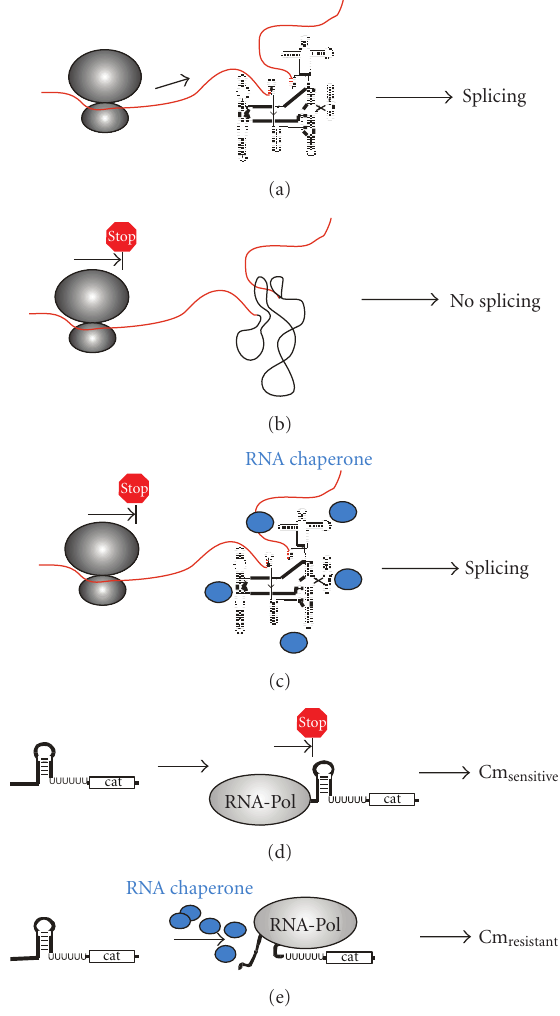
Figure 2: In vivo chaperone assays. (a–c) show the in vivo folding trap assay: (a) In the presence of translation, the group I intron folds correctly. (b) In the absence of translation, misfolding of the group I intron occurs. (c) Proteins with RNA chaperone activity loosen misfolded structures and splicing can proceed. (d–e) show the in vivo antitranscription termination assay. (d) The transcription terminator stem folds and transcription of the chloramphenicol acetyl transferase cannot proceed. Thus, cells are chloramphenicol sensitive. (e) Proteins with RNA chaperone activity loosen the terminator stem, transcription can occur, and the cells become chloramphenicol